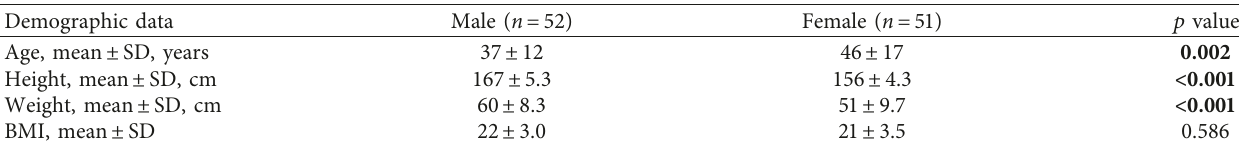
Figure 1: Axial CT slices with the highlighted segmented tissues and the three-dimensional reconstruction of the segmented issues: (a) extraocular muscle, (b) orbit fat, (c) intraorbital optic nerve, (d) orbital bony cavity. Table 1: Demographic characteristics.